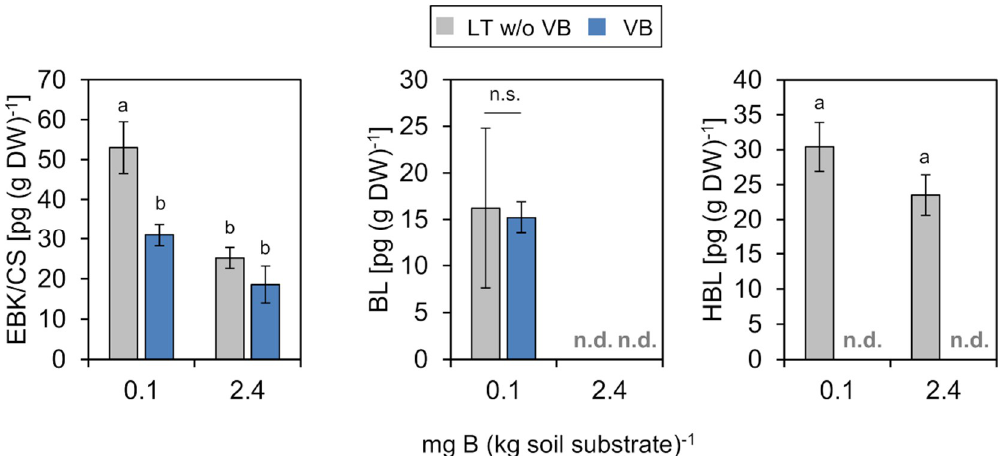
Figure 6. Concentrations of brassinosteroids in vascular bundles (VB) or leaf tissue without VB (LT w/o VB) of P. major plants grown on low B (0.1 mg B (kg soil substrate) −1 ) or B-sufficient (2.4 mg B (kg soil substrate) −1 ) soil substrate. EBK/CS (epicastasterone/castasterone) and HBL (homobrassinolide) accumulate in non-vascular tissue. CS and BL (brassinolide) concentrations increased in both tissues of B-deficient plants. Bars represent averages from three different measurements ± SD. n.d.= not detected. Error bar labels with different letters indicate significant differences at p < 0.05 between treatments and tissues according to One-way ANOVA with post-hoc Tukey test. n.s. = no significant differences ( p > 0.05).